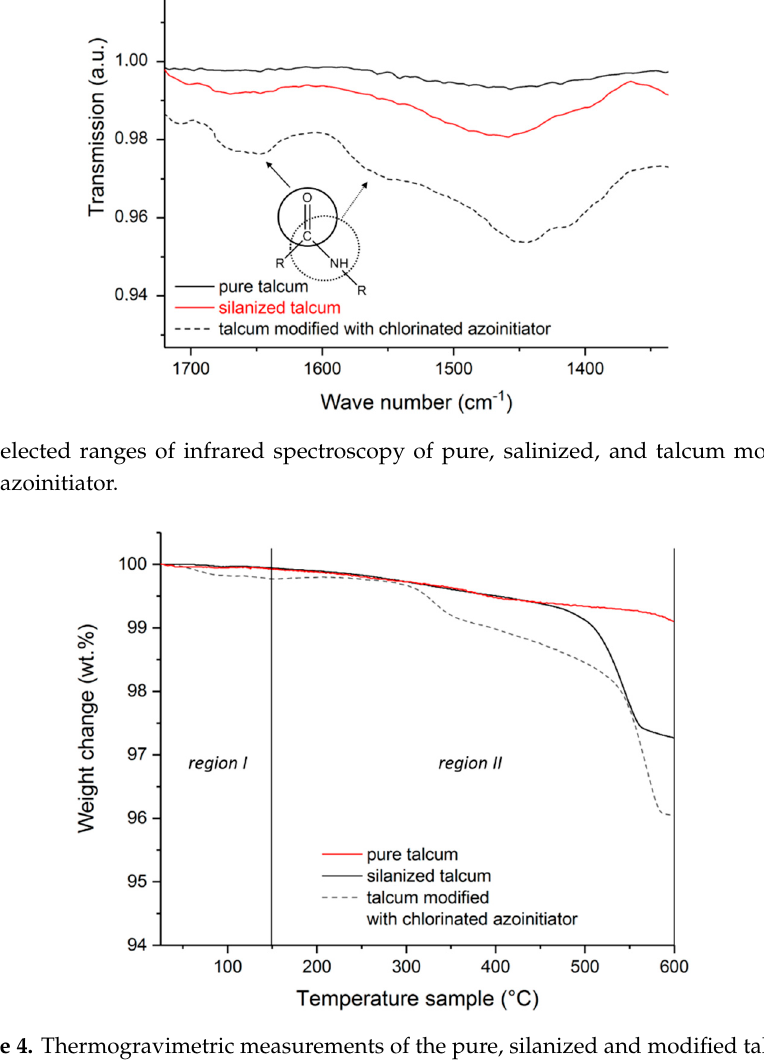
Figure 4. Thermogravimetric measurements of the pure, silanized and modified talcum.